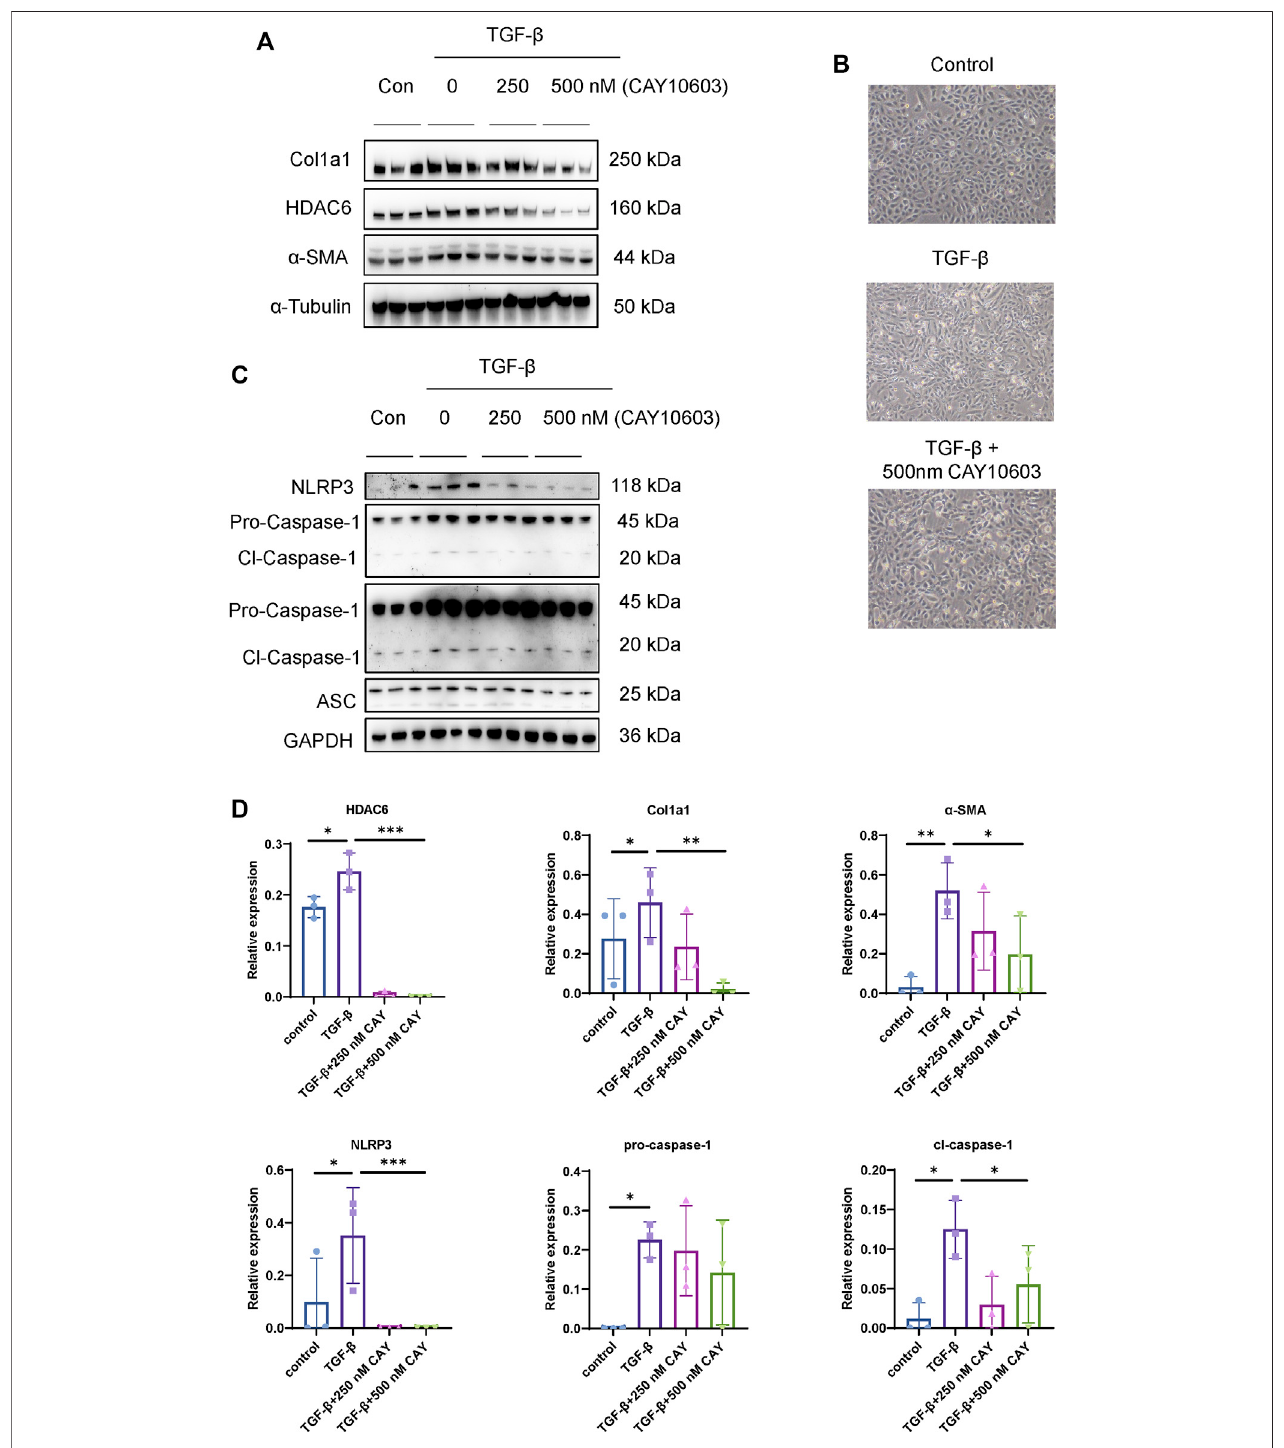
FIGURE6| HDAC6inhibitionreducedNLRP3activationinrenaltubularcells. (A) RepresentativewesternblotanalysisofHDAC6,Col1a,and α -SMAlevelsinHK-2 cells treated with TGF- β with or without CAY10603 treatment. (B) Representative image of the morphology of HK-2 cells treated with TGF- β with or without CAY10603 treatment. (C) Representative western blot analysis of NLRP3, ASC, and Caspase-1 levels in HK-2 cells treated with TGF- β with or without CAY10603 treatment. (D) Quanti fi cation of HDAC6, Col1a1, α -SMA, NLRP3, pro-Caspase-1, and Clevaed-Caspase-1. * p < 0.05; ** p < 0.01; *** p < 0.001.